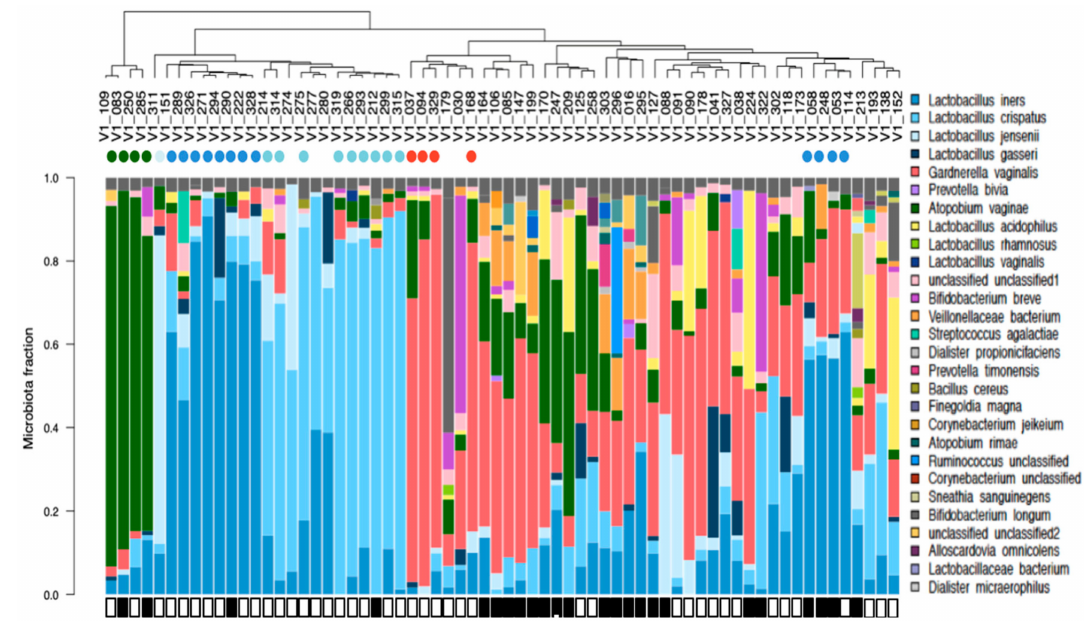
Figure 2. Vaginal microbiota clustered by bacterial similarity in pregnant women prior to treatment, at 13 weeks of gestation (n = 66). Each bar represents the vaginal microbiota of a single woman and corresponds to the participant identification (ID) number labeled in the dendogram, clustered using average linkage cluster analysis. Species found in > 1% abundance are represented by a unique color. Species with < 1% abundance in the sample are pooled into a single fraction at the top of the bar in grey color. Women who have a single bacterial species which dominated more than 40% of their vaginal microbiota are identified with a color dot below their identification number that corresponds to the dominant species ( Dark green, Atopobium vaginae, n = 4; Very light blue, Lactobacillus (L.) jensenii, n = 1; blue, L. iners, n = 12; light blue, L. crispatus, n = 9 and red, Gardnerella vaginalis, n = 4). Black rectangles are used to denote women with a bacterial vaginosis (BV) Nugent score, and white rectangles are used to identify women with an Intermediate Nugent